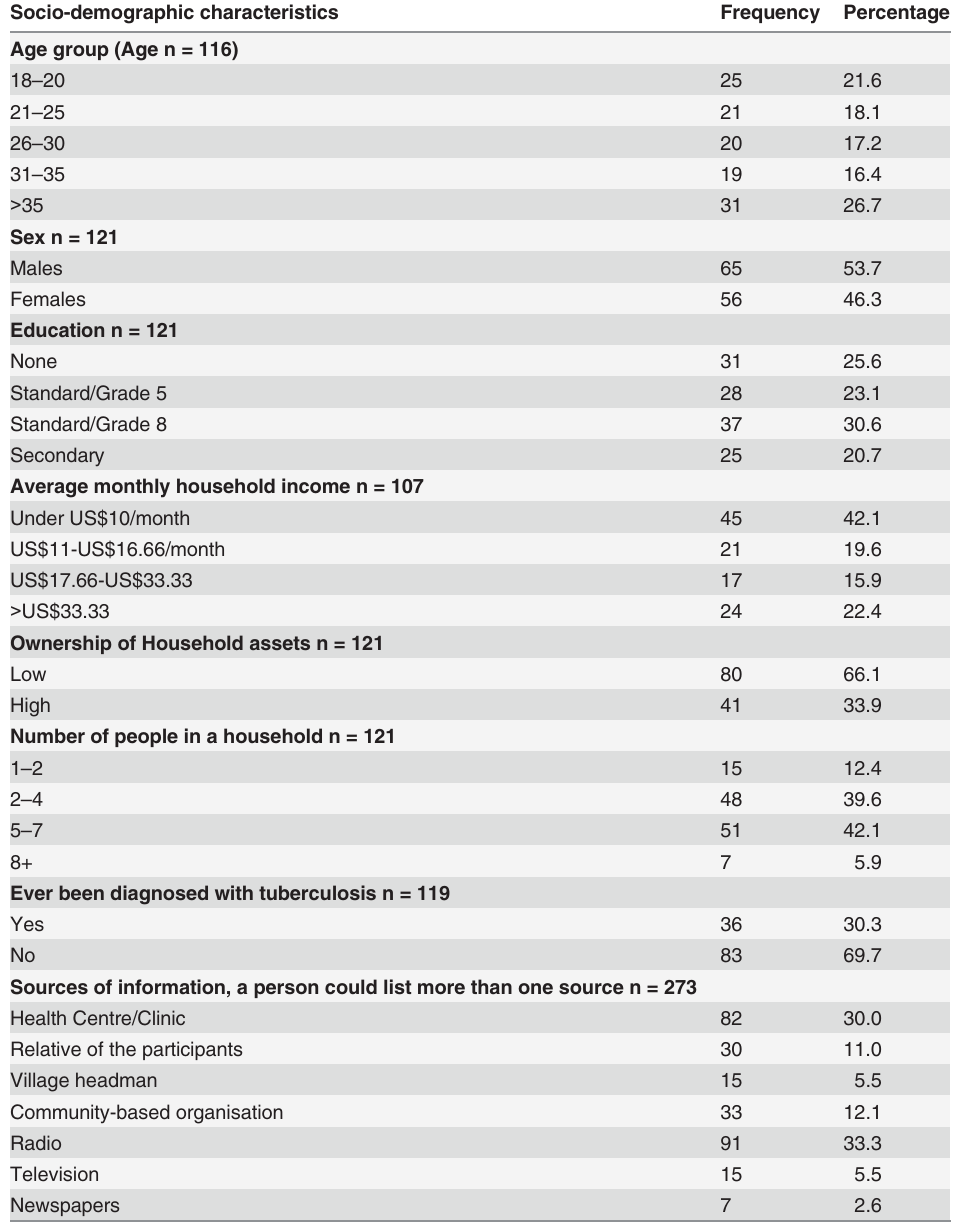
Table 1. Distribution of socio-demographic characteristics of the participants. Socio-demographic